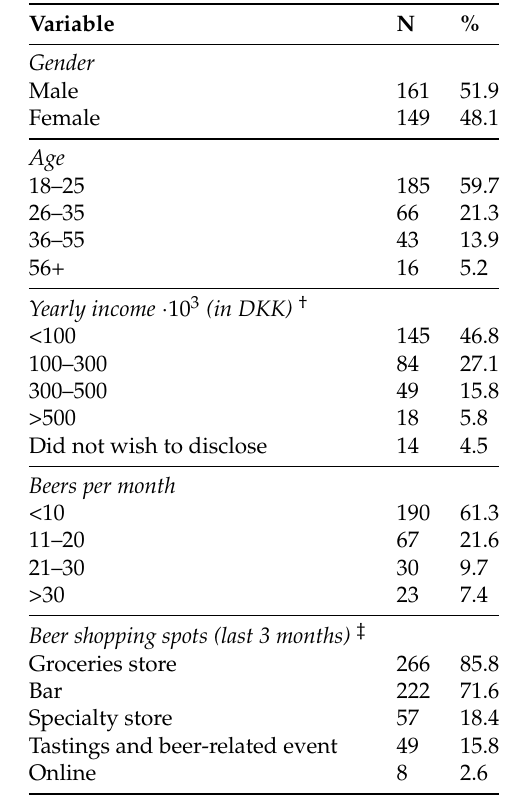
Table 1. Background information on the